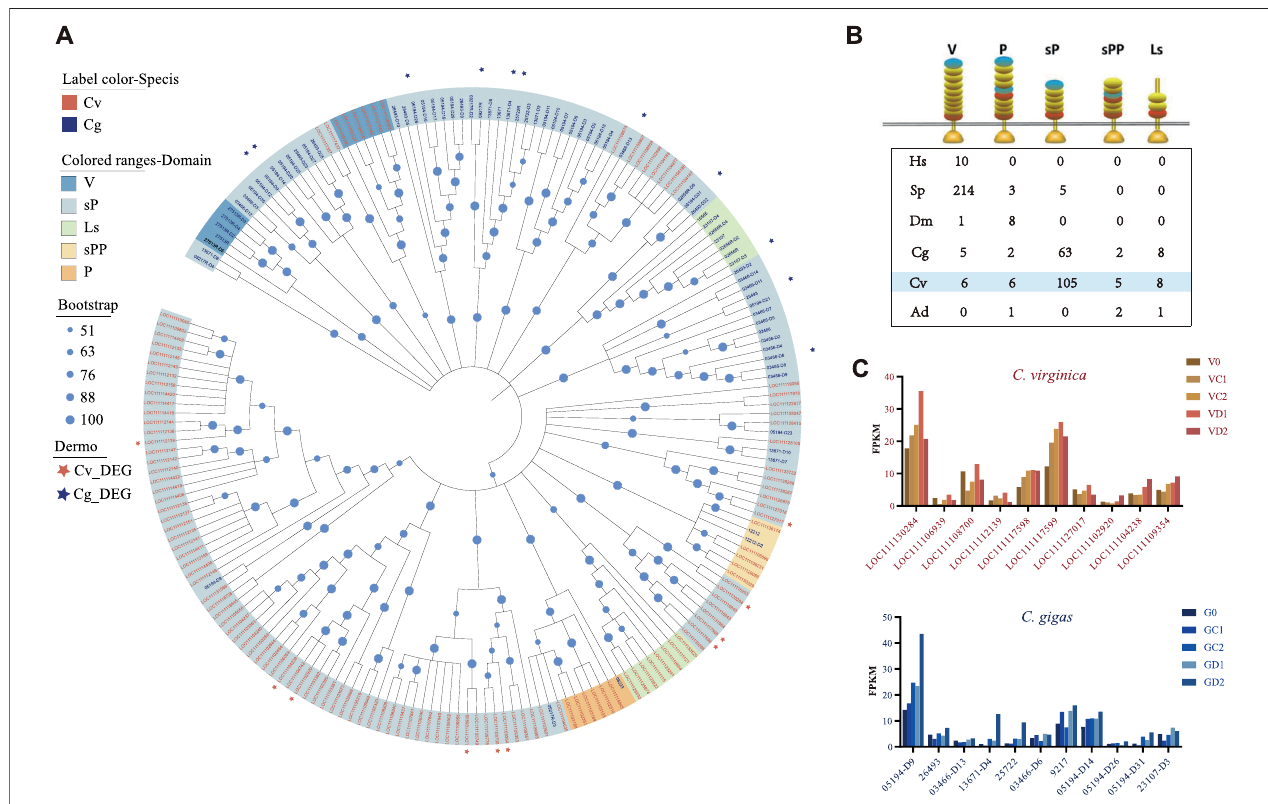
FIGURE5| ExpansionofTLRsanddivergentexpressionpatternsunder P.marinus challengebetween C.gigas and C.virginica. (A) ,Phylogenetictreeconstructed with the maximum likelihood method showing lineage-speci fi c expansion of TLRs in C. gigas (red font) and C. virginica (blue font). Red and blue asterisks represent the differentially expressed TLRs in C. gigas and C. virginica , respectively. (B) , Comparison of TLRs with different domain architectures in: human ( Homo sapiens -Hs), sea urchin( Strongylocentrotuspurpuratus -SP),fruit fl y( Drosophilamelanogaster -Dm),Paci fi coyster( Crassostreagigas -Cg),Easternoyster( Crassostreavirginica- Cv), and staghorn coral ( Acropora digitifera -Ad). LRRCT in red, LRRNT in blue and LRR in yellow. Toll/interleukin-1 receptor (TIR) domains are shown as gold triangles. (C) , Diverse expression pattern of the differentially expressed TLRs, marked with asterisks in (A) , during P. marinus challenge in C. gigas (Top) and C. virginica